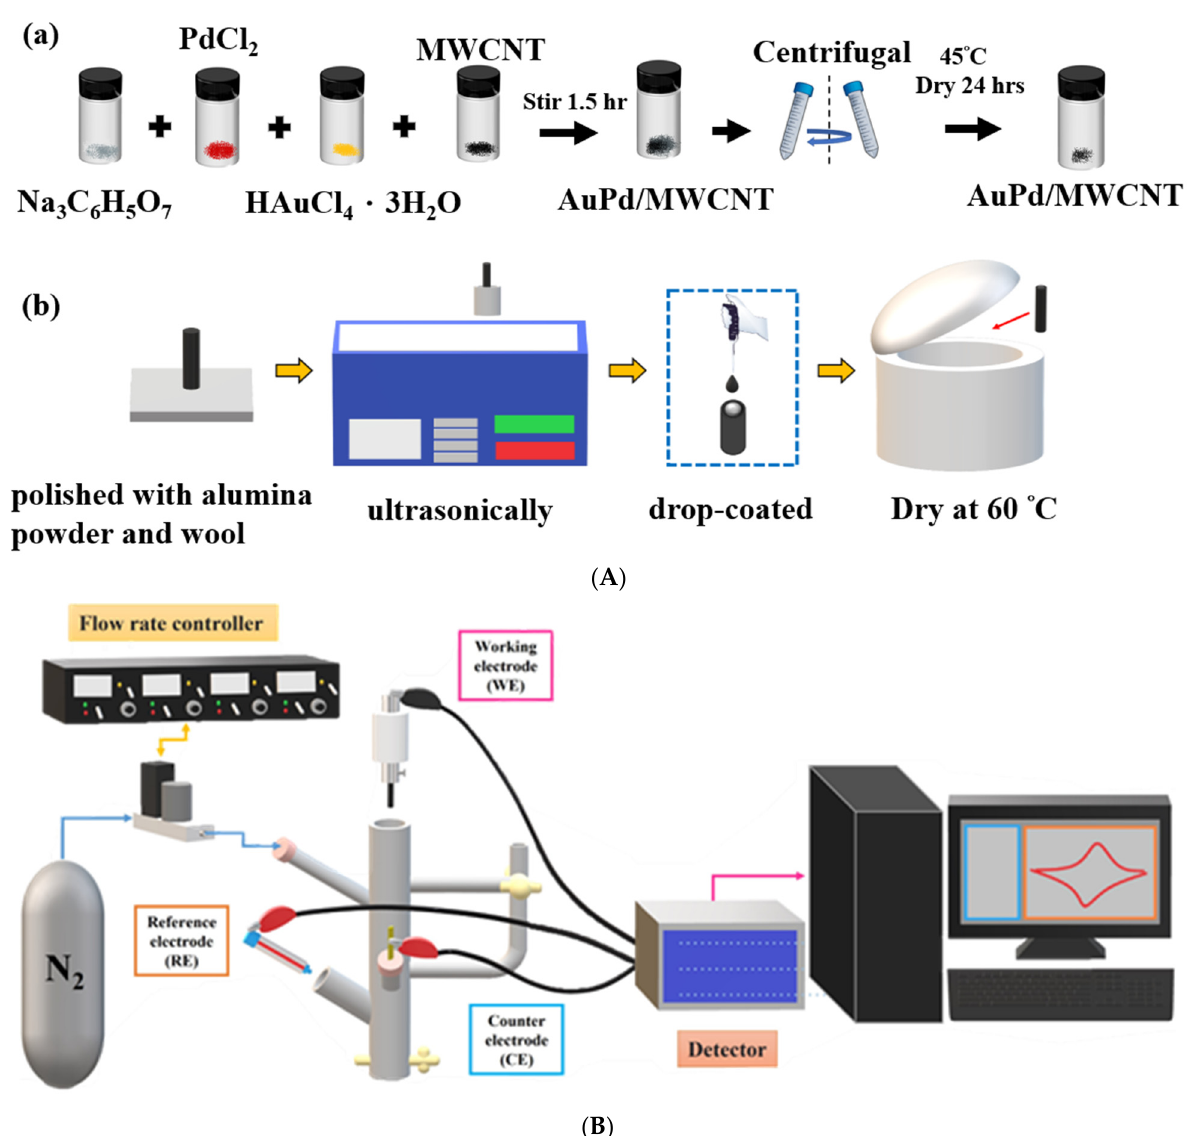
Figure 1 . ( A ) ( a ) Synthesis of the sensing materials and ( b ) preparation of the sensing electrode for the detecting system. ( B ) The electrochemical dopamine detection system.